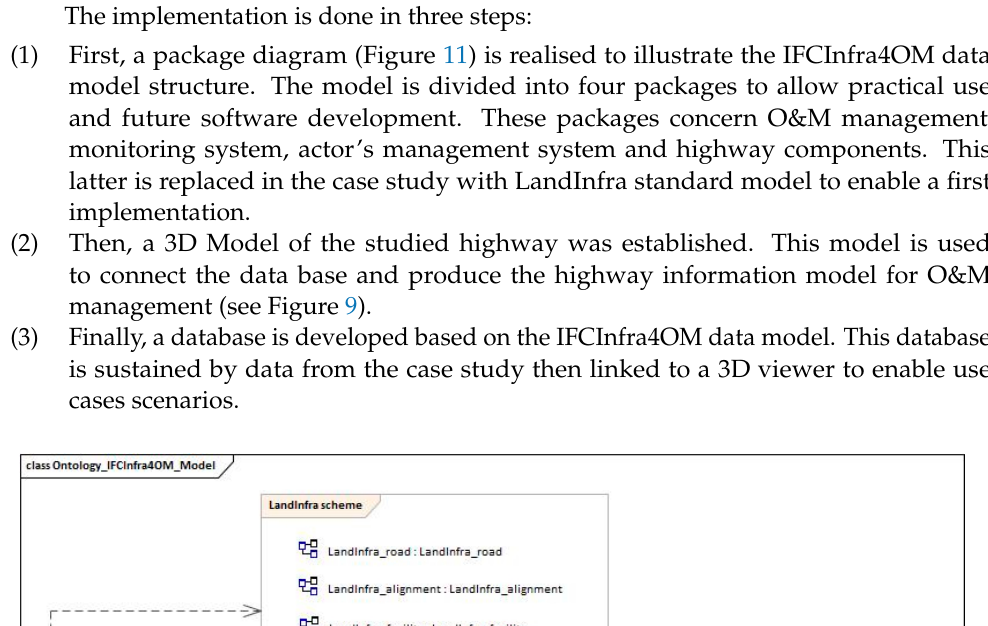
Figure 10. IFCInfra4OM Case Study Implementation Diagram.